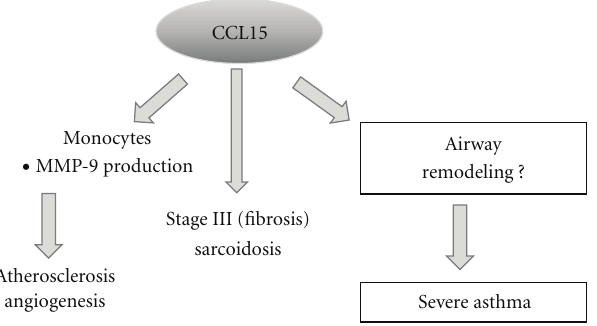
Figure 3: Other e ff ects of CCL15. It has been shown that CCL15 has a role in atherosclerosis via macrophage activation, and that it pro- motes angiogenesis in lung cancer. CCL15 has also been suggested to show an association with the fibrotic stage of sarcoidosis, but its role in airway remodeling remains